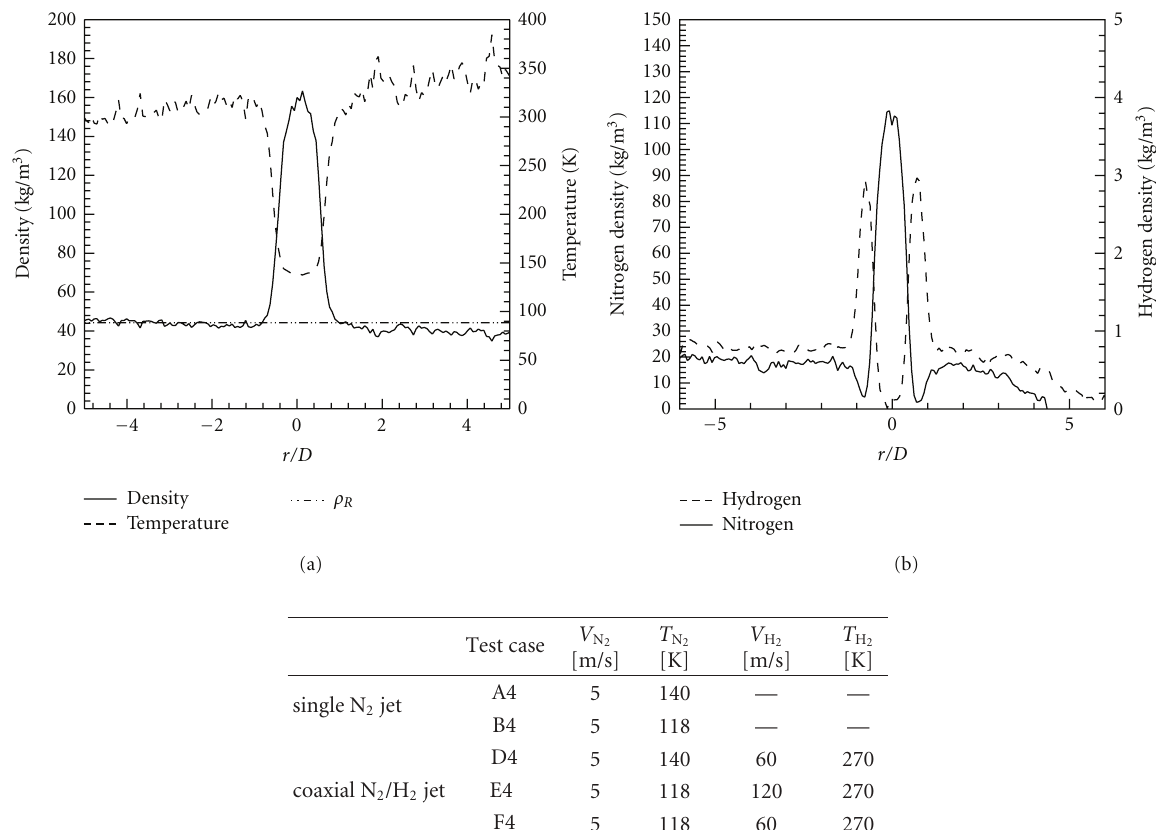
Figure 19: (a) Radial N 2 density profile for test case A4 (single jet), 2mm ( x/D = 1 . 05) downstream of the coaxial injector exit. (b) Radial N 2 and H 2 density profiles for coaxial LN 2 / H 2 injection for test case D4, 2mm ( x/D = 1 . 05) downstream the injector exit. Laser beam direction is from left to right. Oschwald et al. [32].